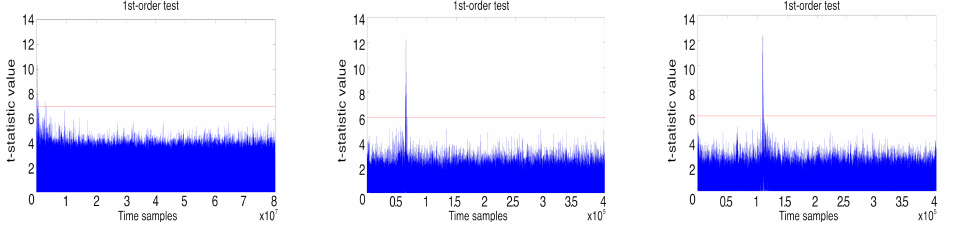
Figure 3: Not aligned traces Figure 4: Alignment around